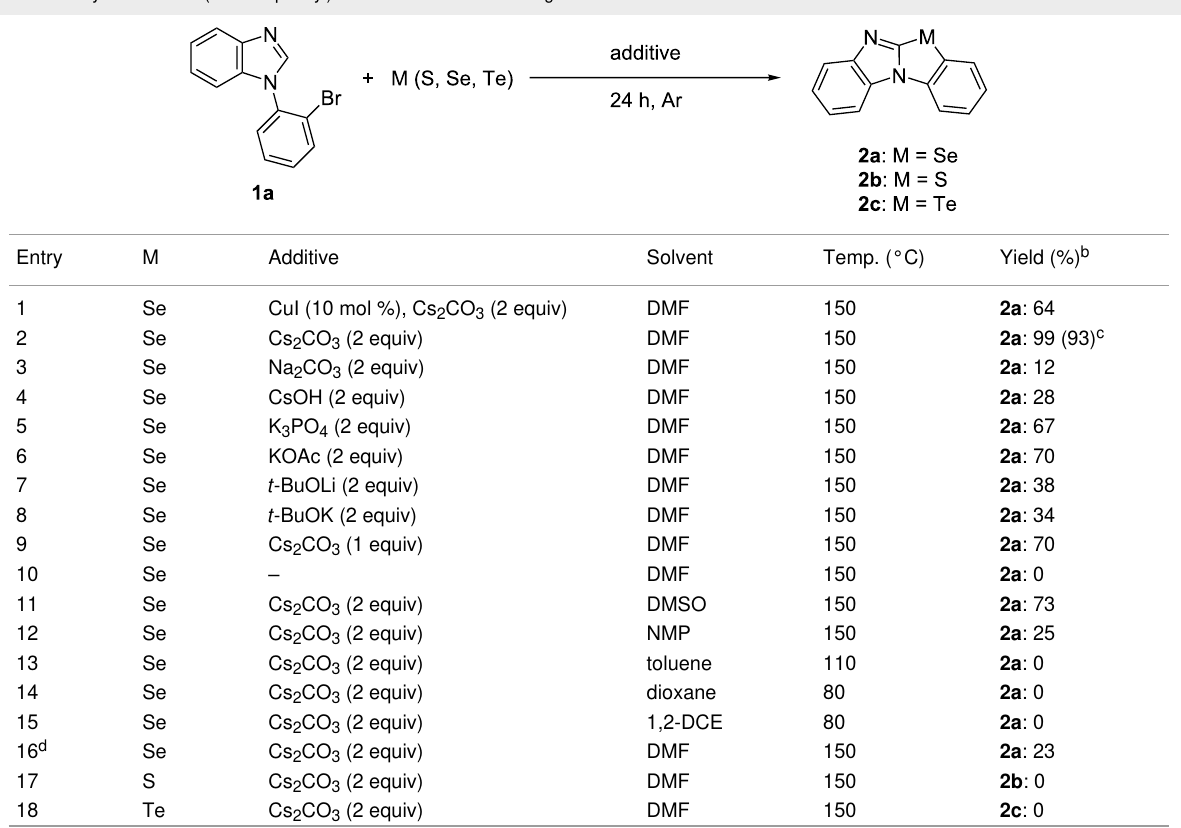
Table 1: Cyclization of 1-(2-bromophenyl)benzimidazoles with chalcogen elements. a